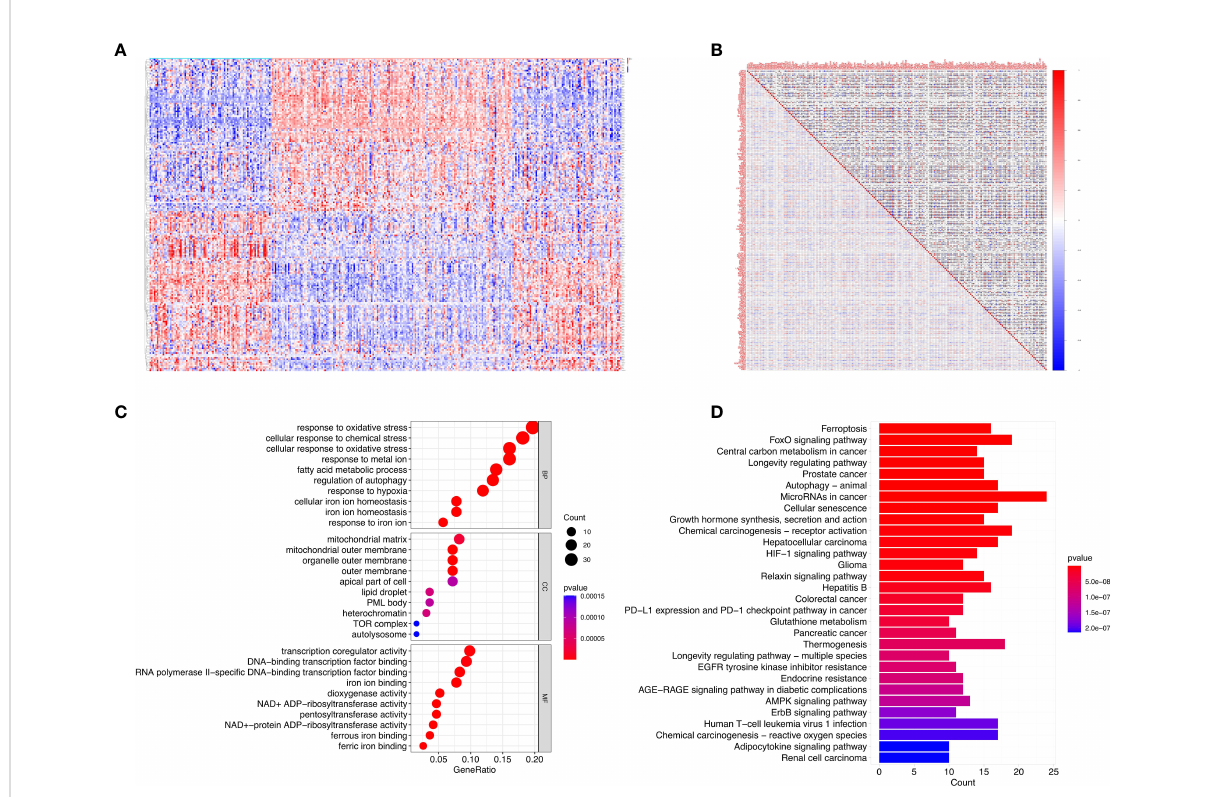
FIGURE 1 DE-FRGs expression levels in psoriasis and functional analyses for the DE-FRGs. (A) Violin plots show expression patterns of DE-FRGs across samples. (B) The correlation of these genes. (C) GO enrichment analyses indicated that DE-FRGs were signi fi cantly related to the function of ‘ response to oxidative stress ’ , ‘ mitochondrial matrix ’ and ‘ transcription coregulator activity ’ . (D) Reactome pathway analyses indicated that the MicroRNAs in cancer, FoxO signaling pathway, and Chemical carcinogenesis − receptor activation were